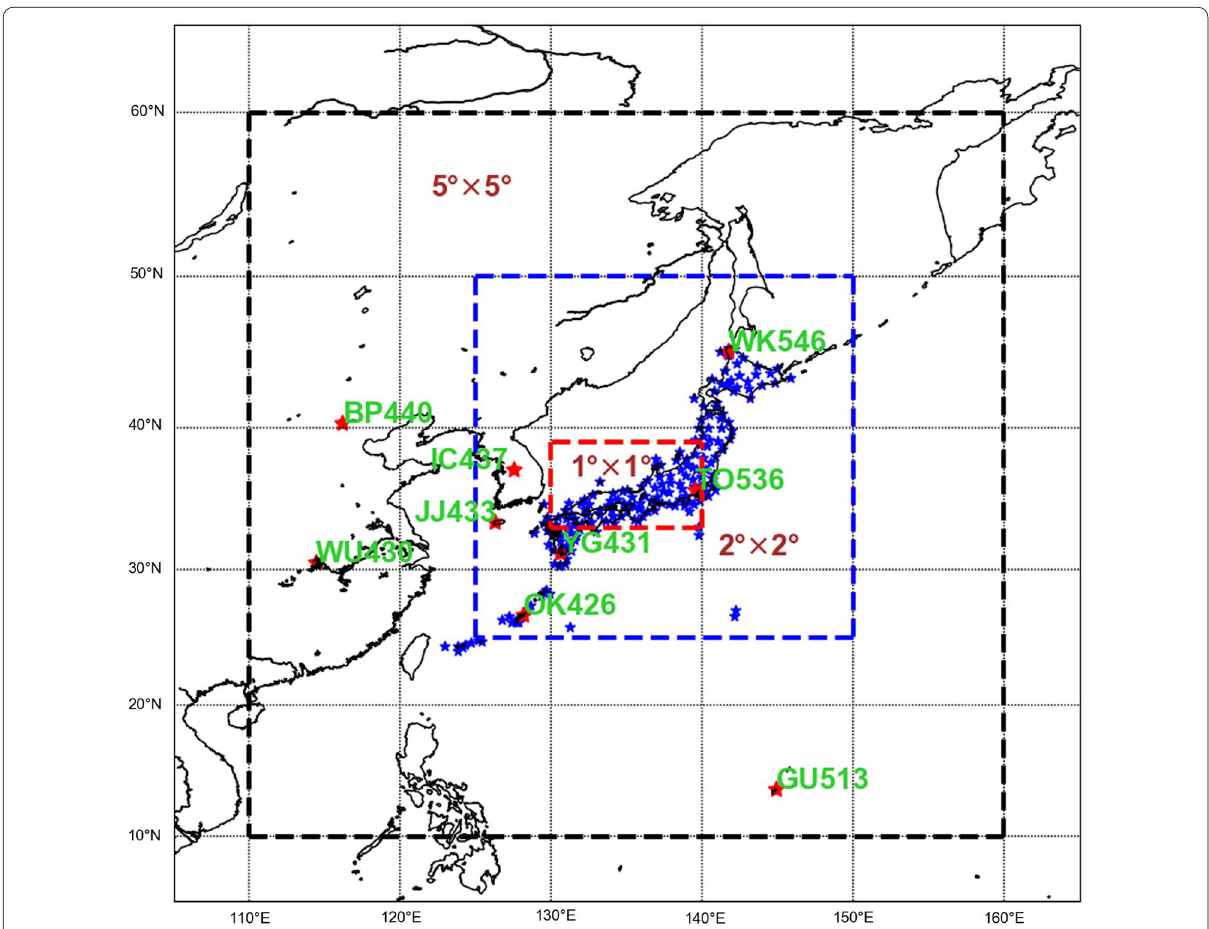
Fig. 1 Image obtained from the works of Ssessanga et al. 2021: a network of GNSS receivers (blue asterisks) and ionosonde stations (solid red stars) used in the analysis. Horizontal boundaries of the different sub-grid regions that compose the overall grid used in computation are marked by solid dashed lines. The sub-grid resolution decreases with increasing distance away from the dense